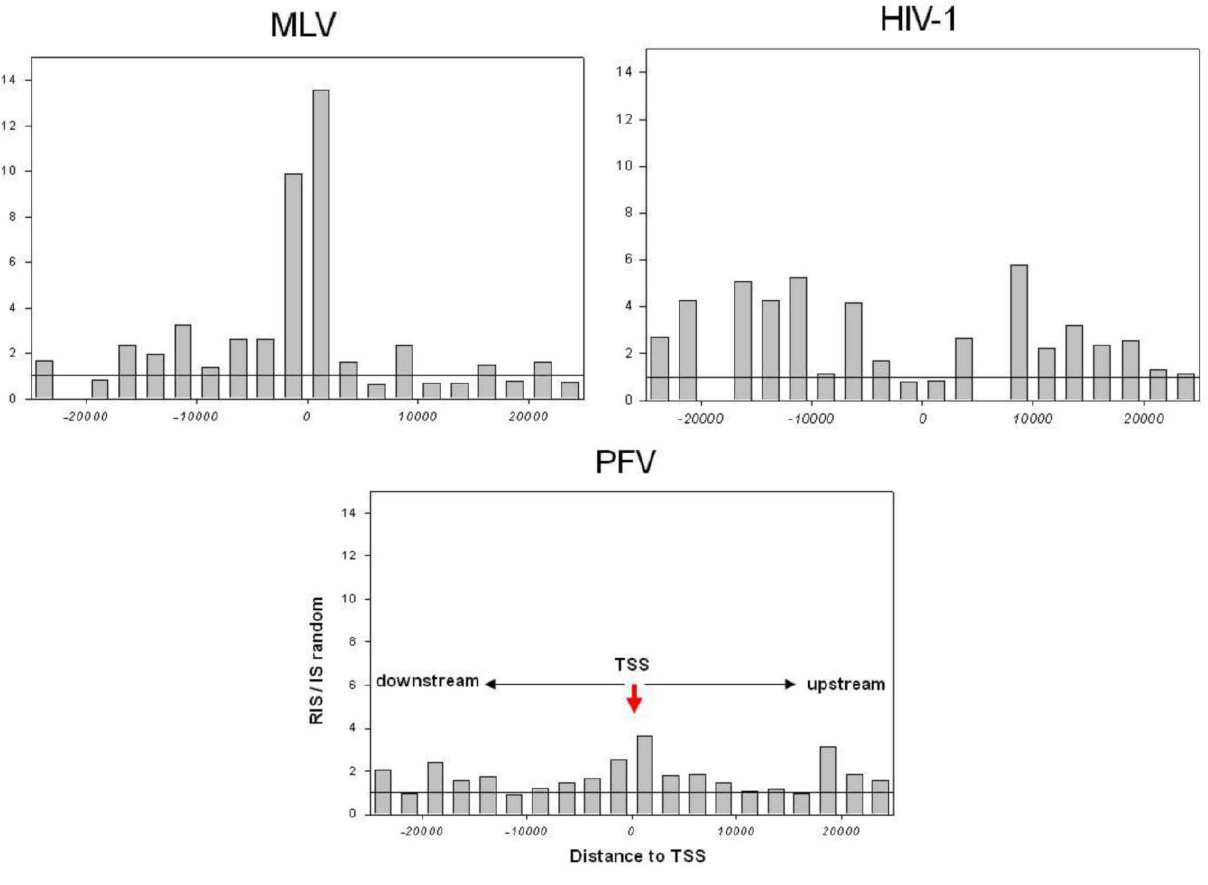
Figure 1. Integration site selection of retroviral based vectors in the cellular